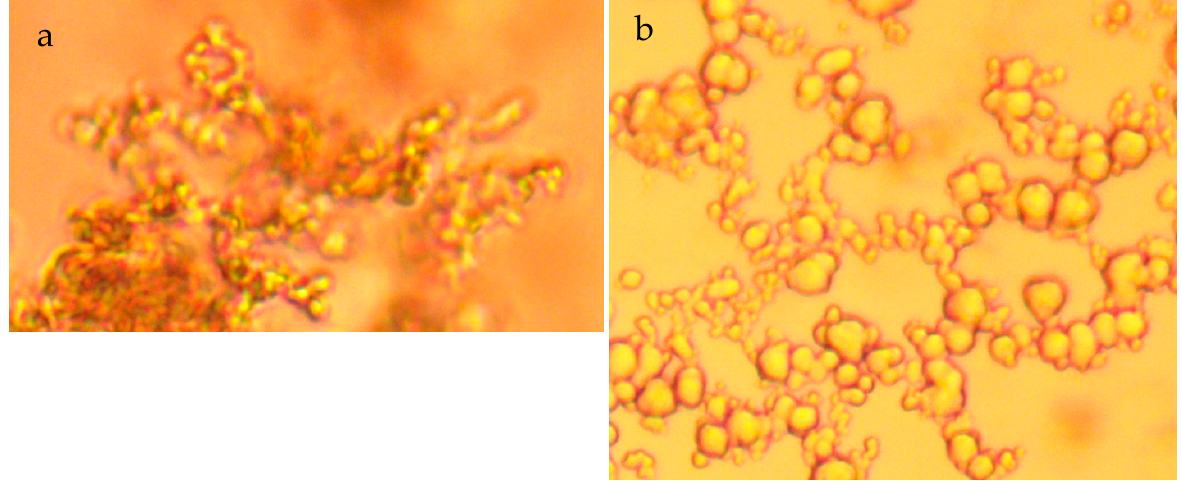
Figure 9. Polar colloidal spheres aggregating to form chains and net-like structures. ( a ), Fe@Ca@Mn@HCOOH polymer. Field of view = 0.07 mm; ( b ), Ca@urea polymer; field of view = 0.093 mm.